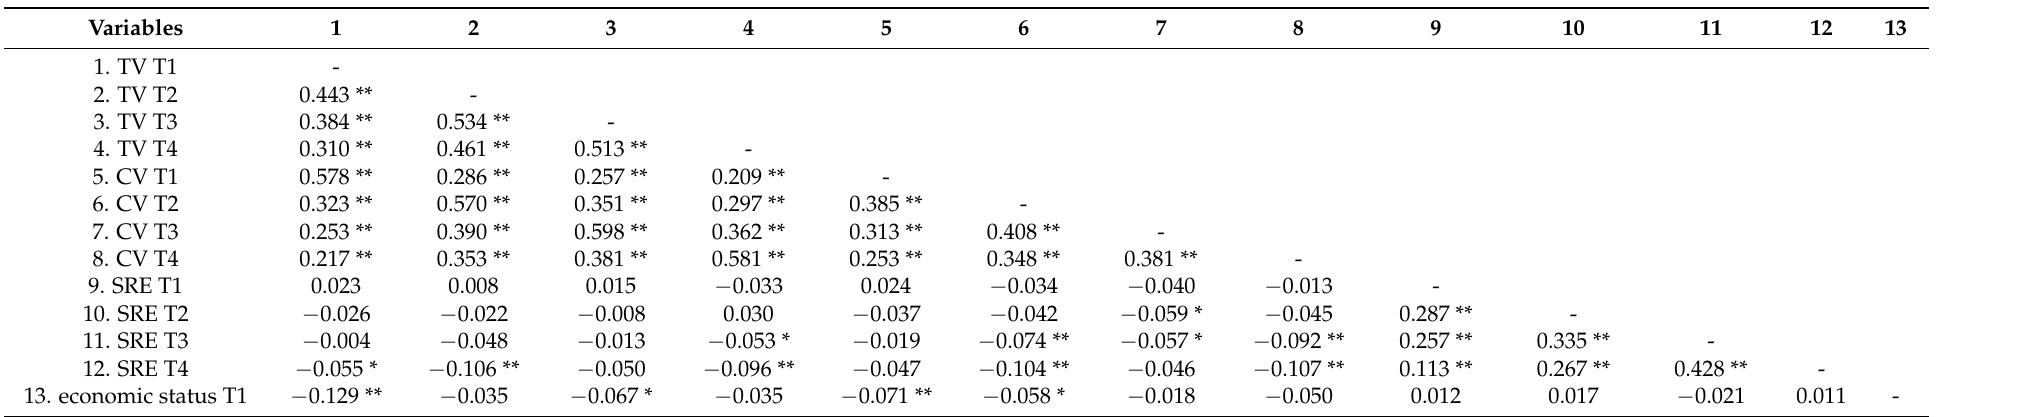
Table 3. Correlations among variables of